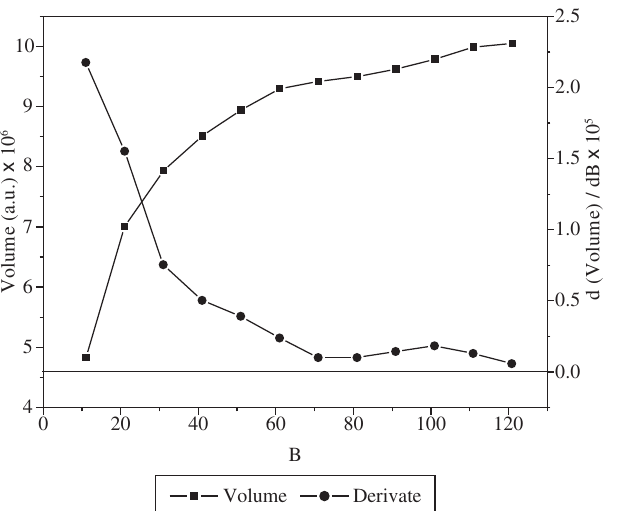
Figure 3. Opening images volume and its derivate as a function of B. Figure 4. a) WTH filter and b) WTH Image of a 0% AIA